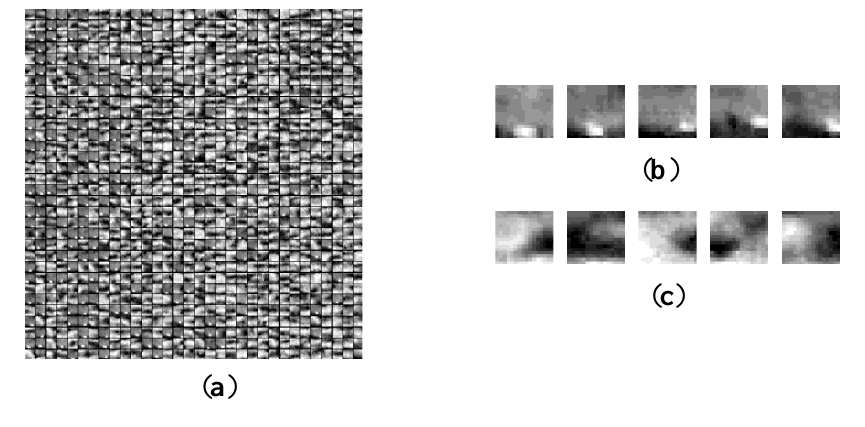
Figure 8. Adaptive over-complete dictionary for Multi-target image. ( a )